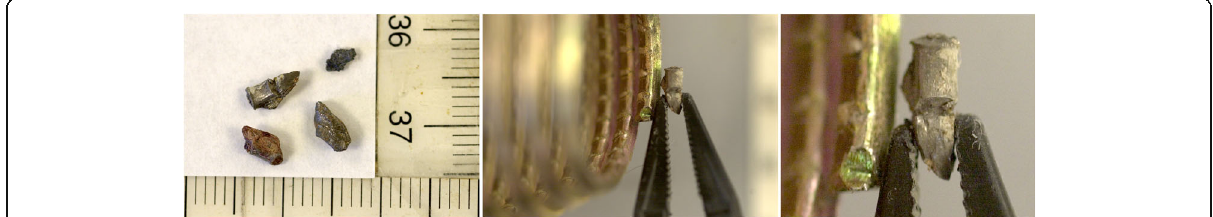
Fig. 2 Metals taken out from the deceased body and comparison to DM-41 steel fragmentation